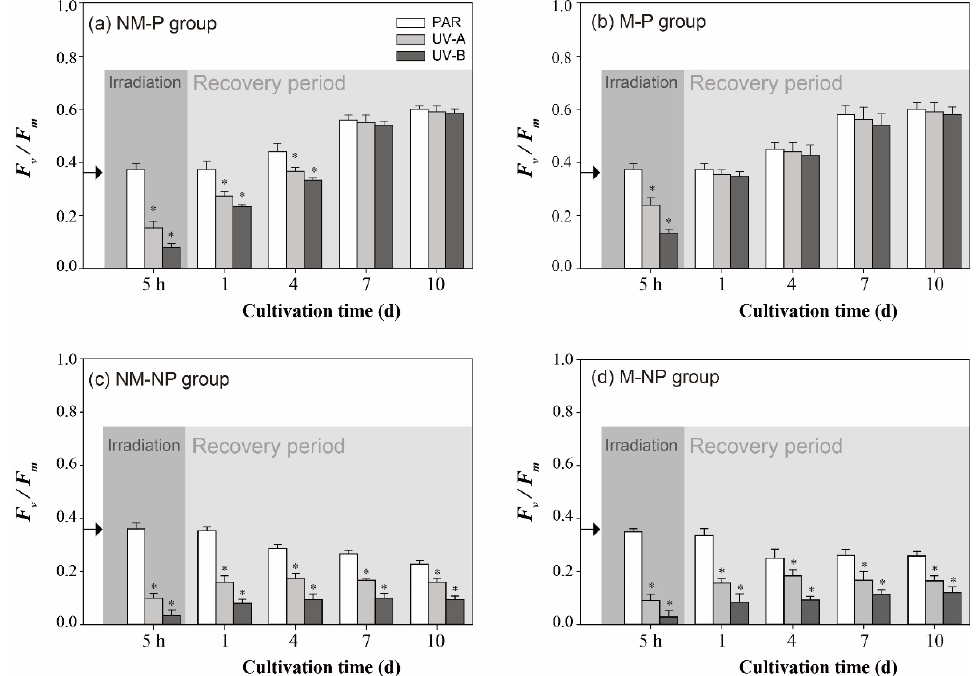
Figure 2. Photosynthetic efficiency of M. aeruginosa after 5 h of irradiation and during the 10-day recovery period in ( a ) NM-P group, ( b ) M-P group, ( c ) NM-NP group and ( d ) M-NP group. (Arrow indicates the initial value of F v / F m ; * indicates a significant difference between UV-A or UV-B treatment and PAR control at p <